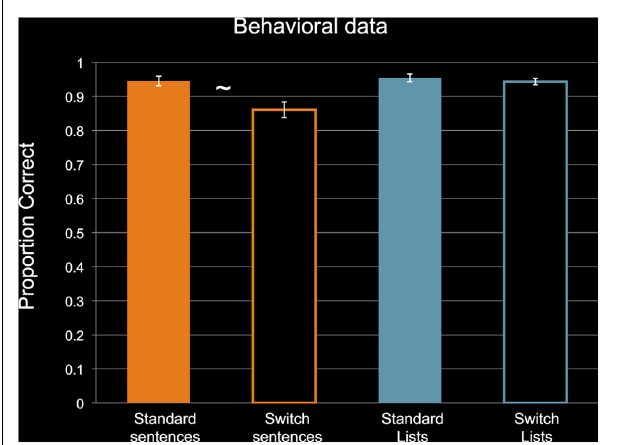
FIGURE 3 | Performance by subjects in the behavioral pre-scan training session. N = 14. Data are collapsed across orientation of cue, and collapsed across constructions in the sentence conditions and right/left arrow in the list conditions. Analysis revealed a significant main effect of STRUCTURE and a significant interaction between STRUCTURE and PERTURBATION . ∼ : marginally significant simple effect of PERTURBATION for sentences ( p = 0.058) at p < 0.025. Error bars indicate standard error of the mean. See text for details of statistical